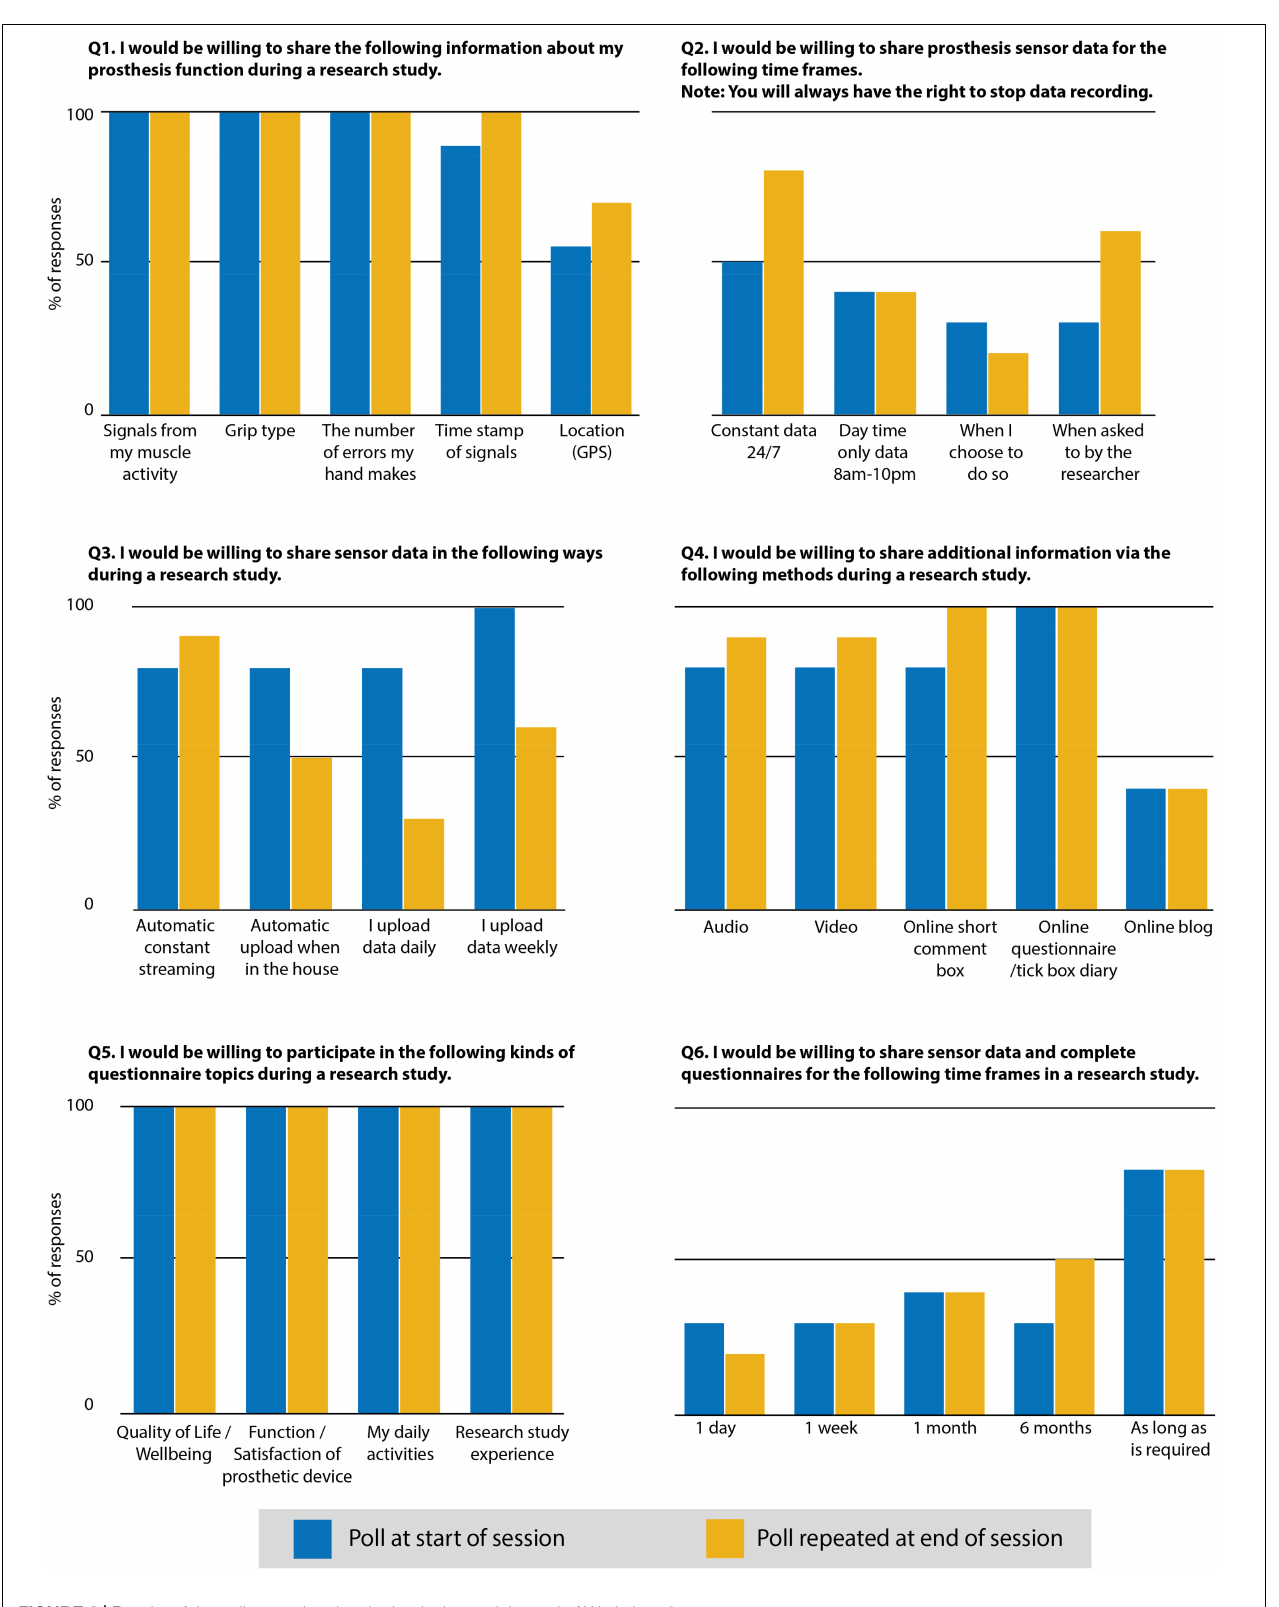
Frontiers in Neuroscience |